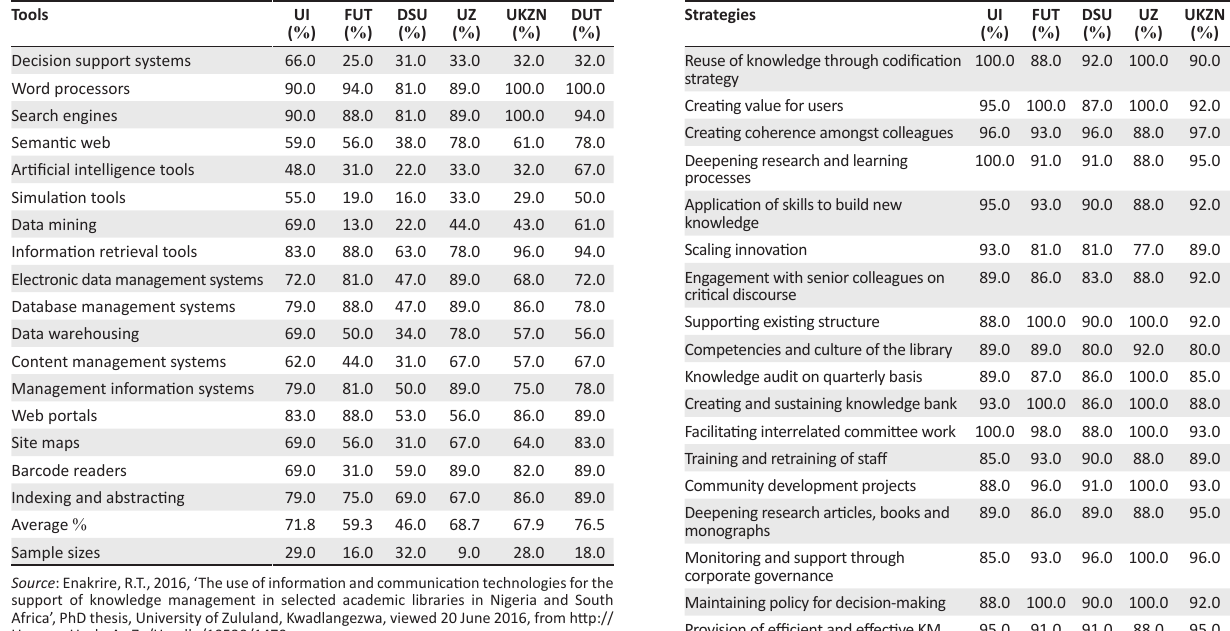
TABLE 3: Strategies for knowledge management practices in academic